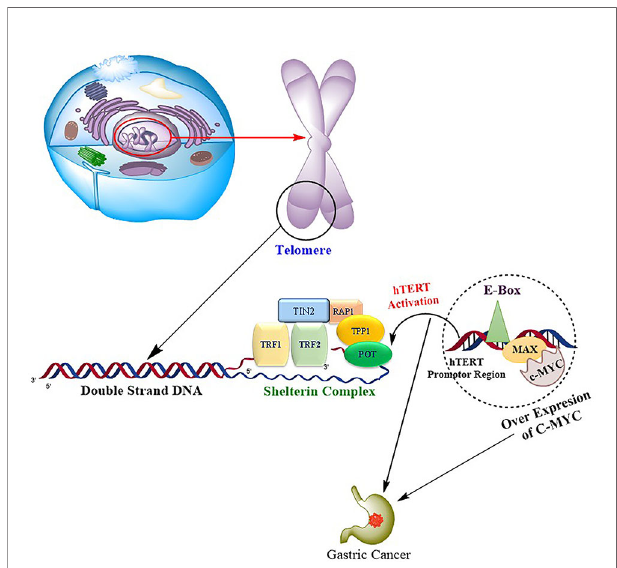
FIGURE 8 | Progression of gastric carcinoma is mediated by the binding of oncogene c-Myc to the hTERT promoter region via transcription factor domains MAD/MAX complex, resulting in upregulation of hTERT, which in turn causes the repeated synthesis of telomeric DNA and drives the cell toward